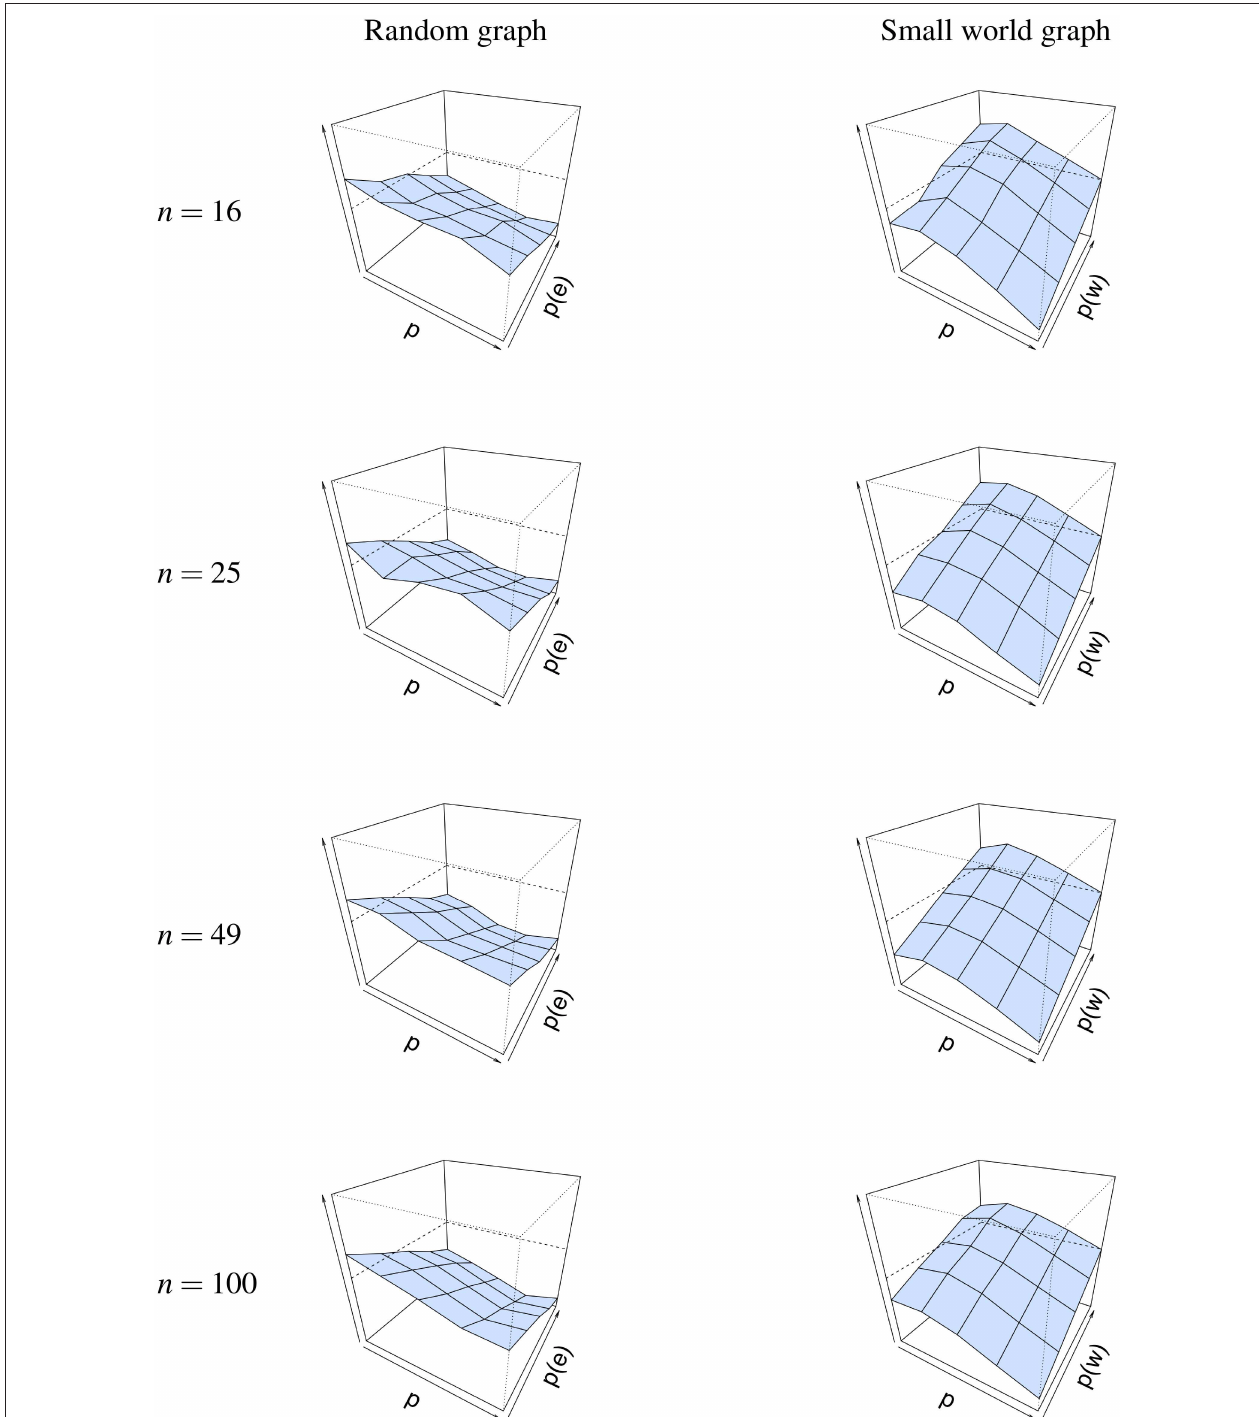
FIGURE 6 | Visualization of the mean absolute differences between p ( e ) and ˆ p ( e ) and p ( w ) and ˆ p ( w ) at T = 50. Mean absolute difference is shown for a random graph (Left column) and a small world graph (Right column) . The x -axis denotes the parameter p for which we simulated data, the z -axis the graph parameter that was used to simulate data ( p ( e ) or p ( w )), and the y -axis the mean absolute difference | 1 | between p ( e )/ p ( w ) and ˆ p ( e )/ ˆ p ( w ). The mean absolute difference ranges between 0 and 1, where a lower value indicates a smaller difference between p ( e )/ p ( w ) and ˆ p ( e )/ ˆ p ( w ).